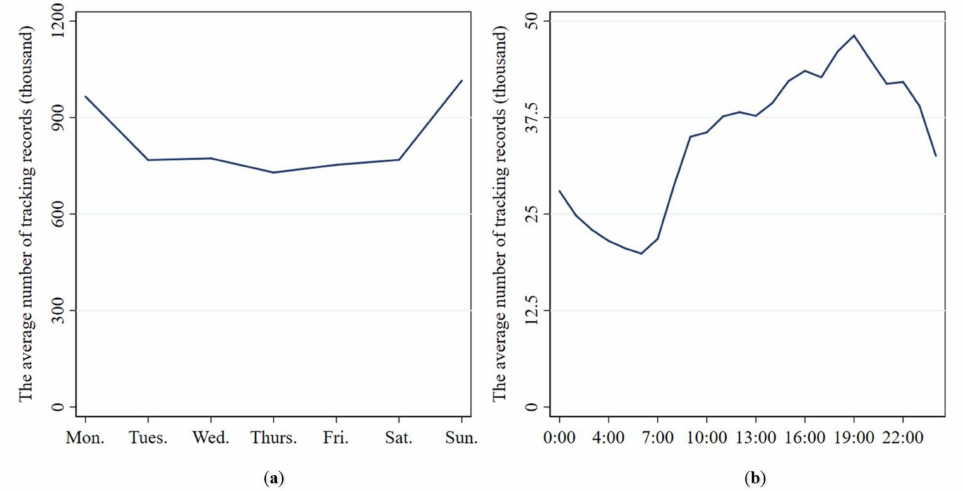
Figure 11. Quantitative distribution of car sharing tracking records in a week ( a ) and in di ff erent time periods ( b